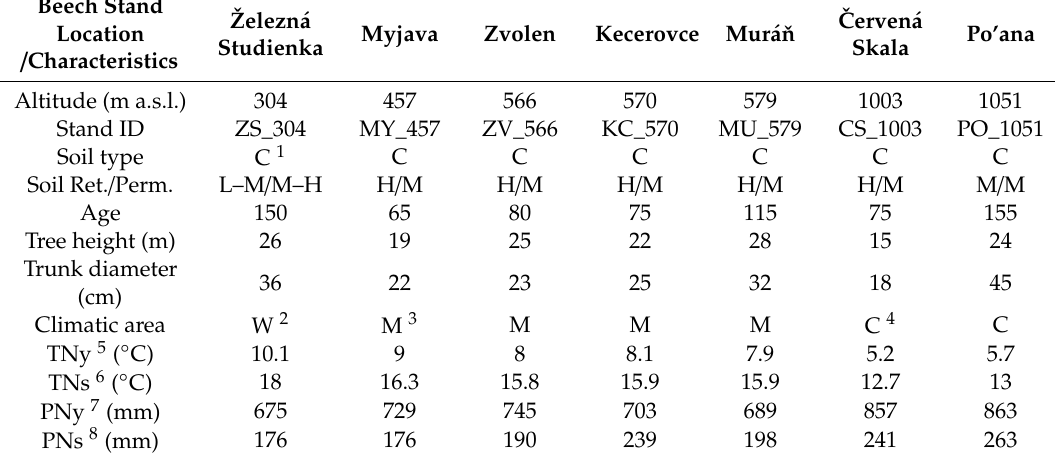
Table 1. The basic characteristics of beech stands were obtained from the website of the National Forest Center ( © NLC Zvolen, 2020) [39]. The stand identifier (ID) consist of the abbreviations of the stand location and the altitude. The characteristics of soils obtained from the soil portal ( © V Ú POP Bratislava): retention capacity (Ret.) and permeability (Perm.) of soil have 3 main degrees—low